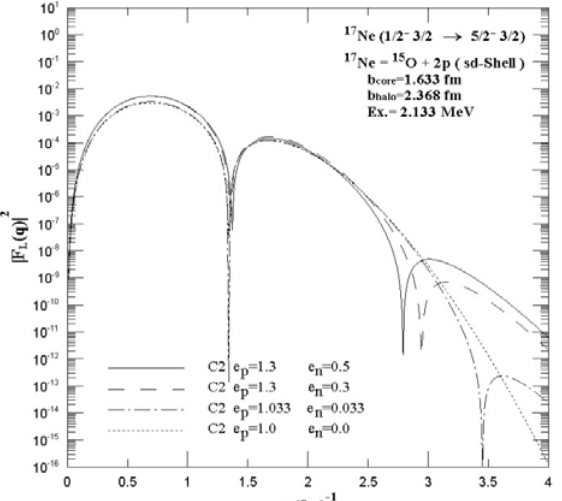
Fig. 9: The calculated inelastic longitudinal C2 form factors of 17 Ne with two protons in sd- shell and for ( 2325   TJ  ) state.